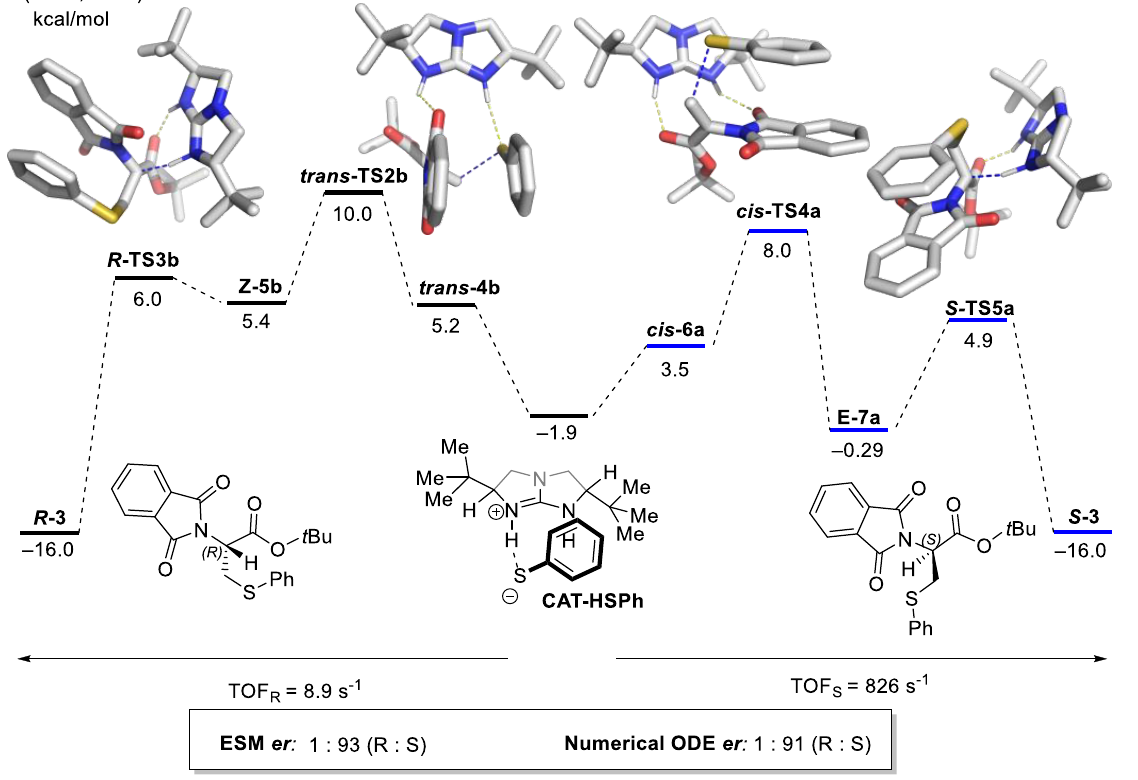
Figure 7. Reprinted with permission from ref [103]. Copyright 2012 American Chemical Society. TOF